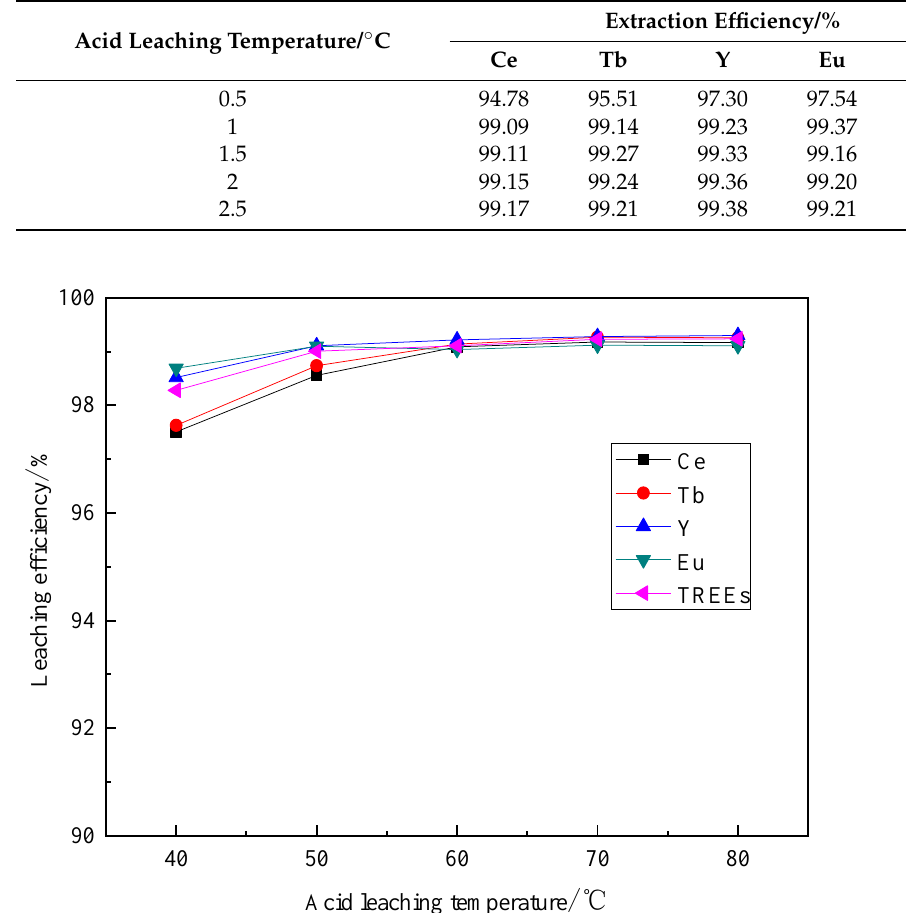
Figure 11. Influence of the acid leaching temperature on the REEs leaching efficiencies (oxygen concentration in the mixed gas of 0.4%, roasting temperature of 700 °C, roasting time of 2.5 h, mass ratio of phosphor powder to alkali 1:3, HCl solution concentration of 4 mol·L −1 , acid leaching time of 1 h, and liquid–solid ratio of 10:1).